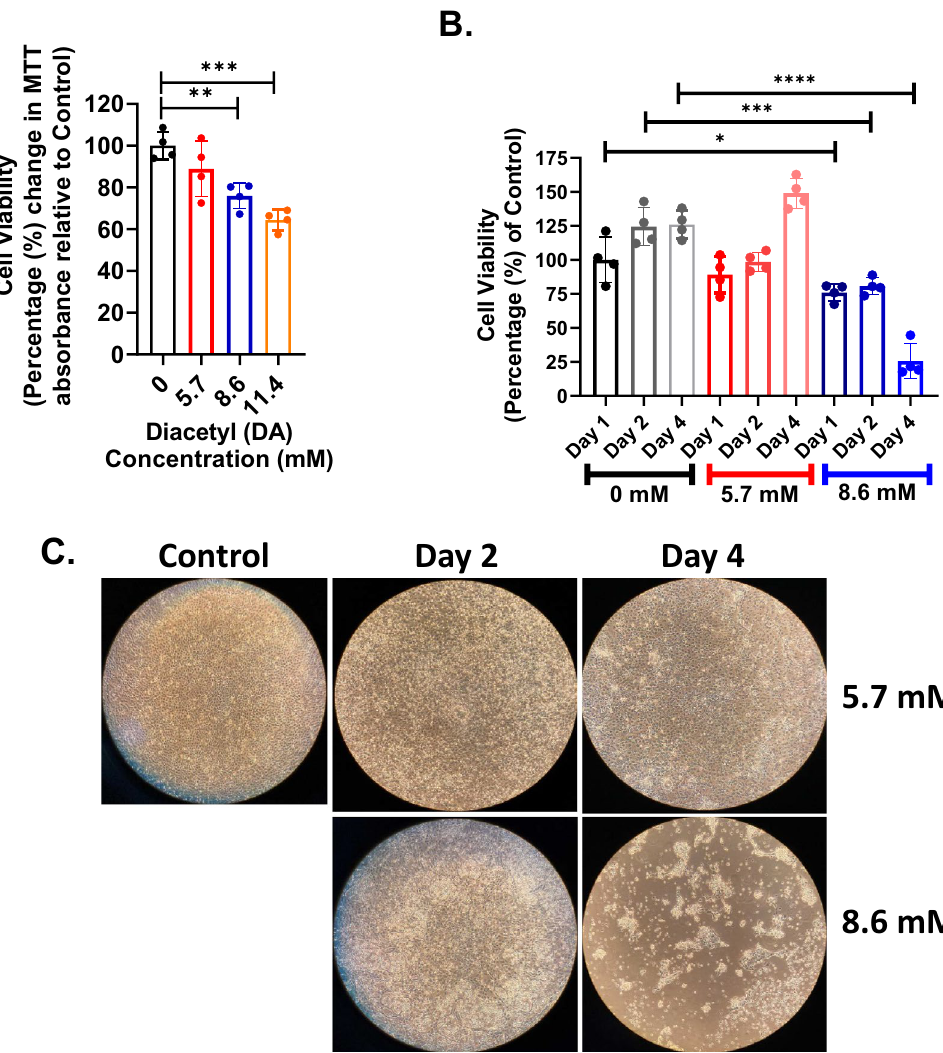
Figure 1. Cell viability with respect to concentration and time after DA exposure. ( A ) Cell viability decreased significantly at Day 1 in airway epithelial cultures exposed to DA concentrations of 8.6 mM and 11.4 mM, but not 5.7 mM DA, compared to PBS-exposed control cultures. MTT was measured within each culture well (n = 4/group) and calculated as a percentage change relative to non-exposed control wells. ( B ) Cell viability with respect to time after exposure (Days 1, 2, and 4) in non-exposed controls (black columns), 5.7 mM DA cultures (red columns), and 8.6 mM DA cultures (blue columns). Cell viability did not differ significantly in 5.7 mM DA-exposed cultures from PBS controls at any time point assessed. In 8.6 mM DA exposures, cell viability differed significantly at Days 1, 2 and 4 compared to controls (ANOVA with Dunnett’s correction, *p < 0.05, ***p < 0.001 and ****p < 0.0001). ( C ) Representative brightfield microscopy images of 16HBE cells at Day 2 and 4 after DA exposure. At Day 4, cell density improved following 5.7 mM DA exposure whereas 8.6 mM-exposed cells showed reduced cell